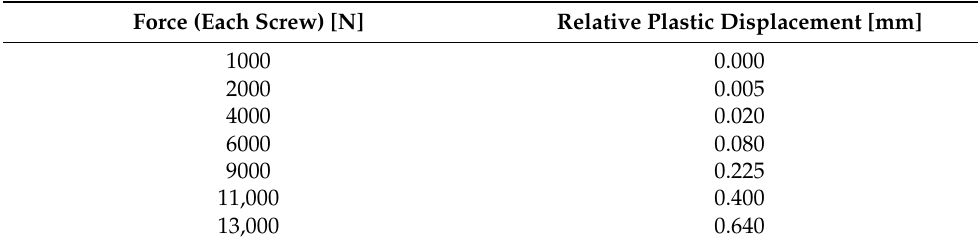
Table 2. Plastic constitutive behavior of the connector elements based on Huth’s experiments [28].